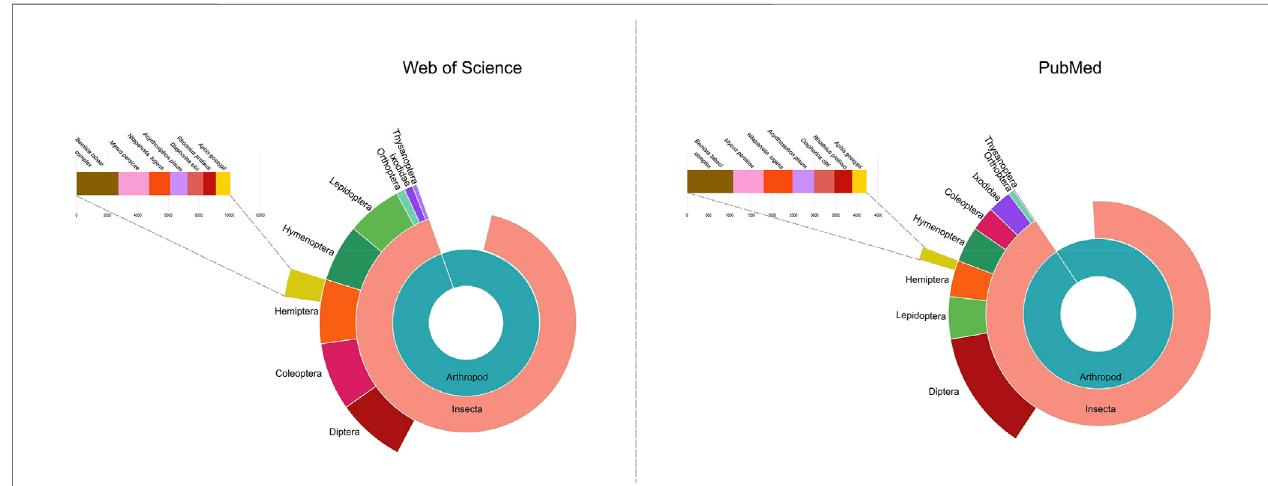
FIGURE 1 | The number of publications on Hemiptera deposited in Web of Science and the National Library of Medicine (United States). The most numerous published species within Hemiptera are also shown. Data from 2012 – 2022